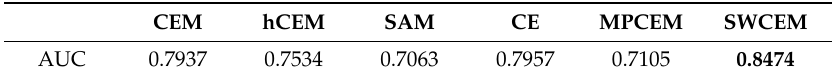
Figure 13. ROC curves of different algorithms on the Chanba Area data.